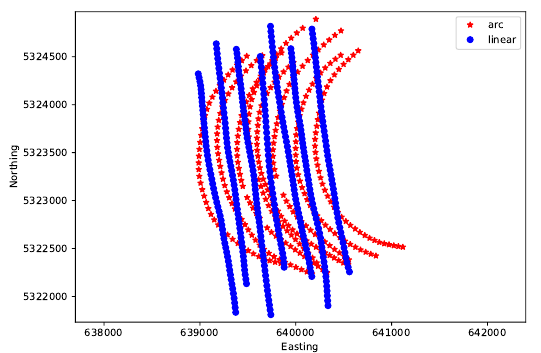
Figure 3. Curved and linear flight strips over Landsberg am Lech .